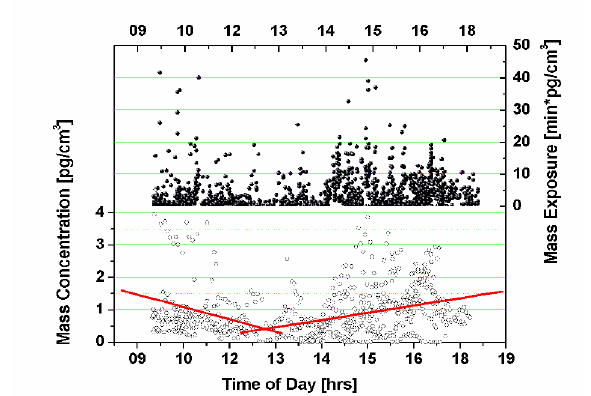
Figure 4 : Diurnal particle mass concentration below and the particle mass exposure above. Using a standard exhaust aerosol conversion density of 1g/cm 3 , it is possible to convert particle concentration data into mass exposure data. The corresponding mass averages are depicted in the lower part of Figure 4; both the particle mass concentration and the particle mass exposure emphasize a similar trend.